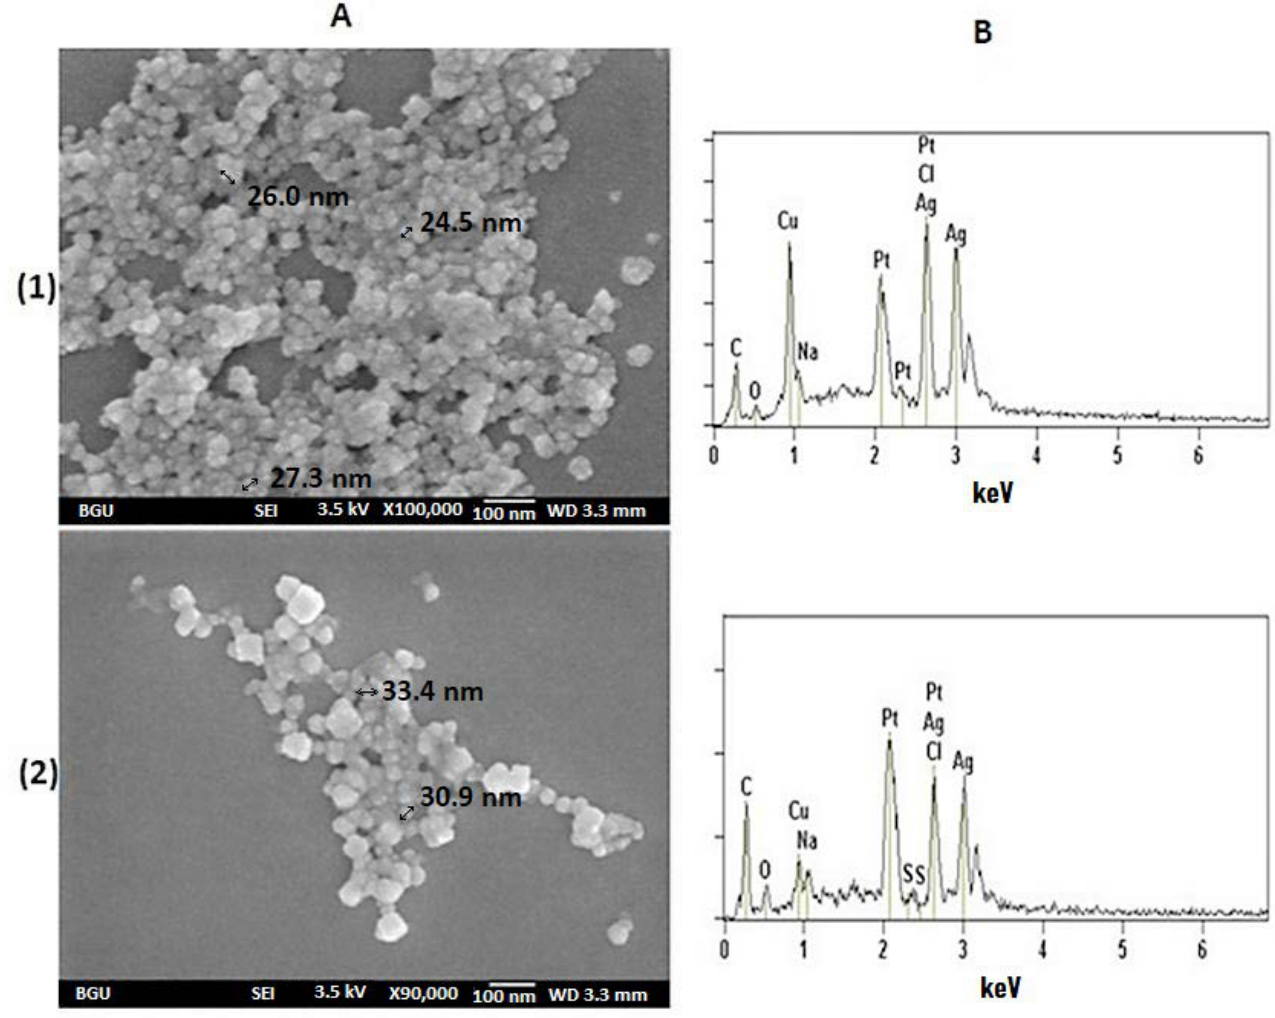
Figure 4. Scanning electron microscopy (SEM) images ( A ) and energy dispersive spectroscopy (EDS) spectra ( B ) of Ag/AgCl NPs nanoparticles biosynthesized in the presence of ( 1 ) Raoultella and ( 2 ) Pantoea